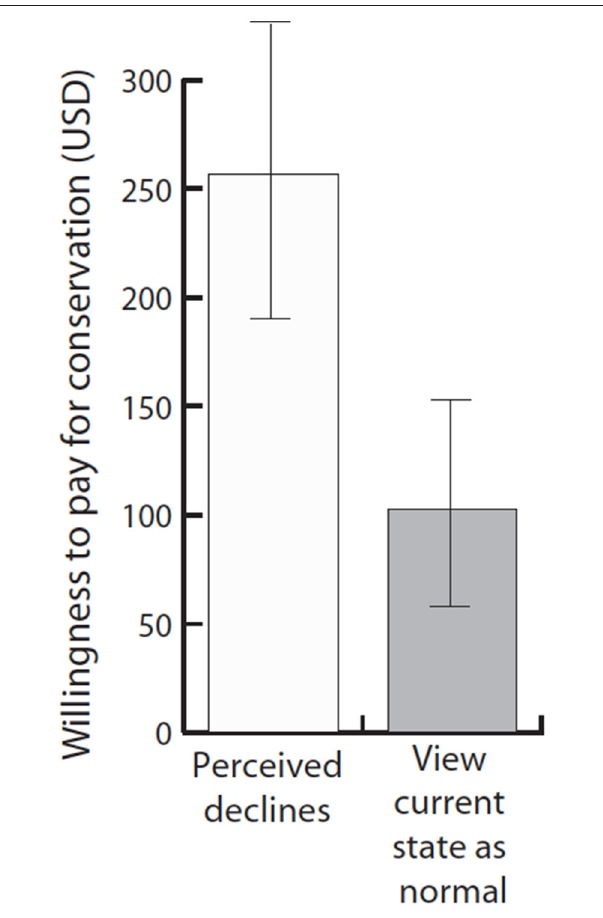
FIGURE 3 | Shifted historical baselines reduce WTP for conservation. Residents who perceived declines in reef health are willing to pay more for a hypothesized coral reef conservation project than are those who view the current state as normal. Values are mean annual WTP for a conservation project predicted to result in a 30% increase in fish catch, a 30% increase in coral coverage, and a 30% decrease in coastal development. Error bars represent 95% confidence intervals.